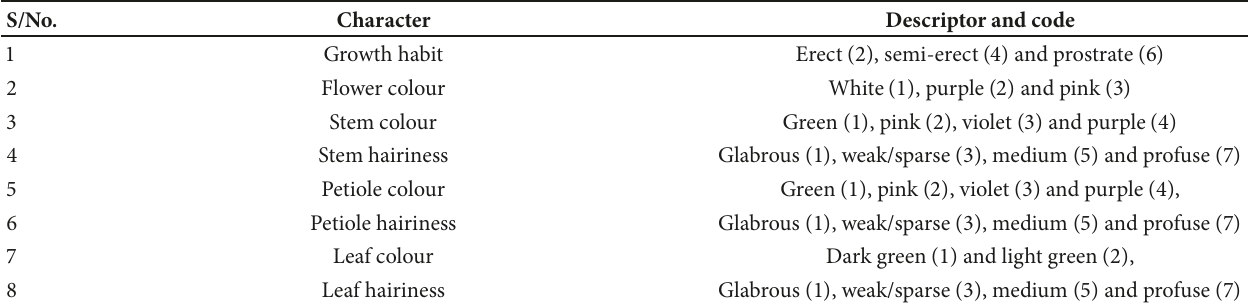
Table 2: Character, descriptor, and codes used for characterization of qualitative traits in spider plant accessions.